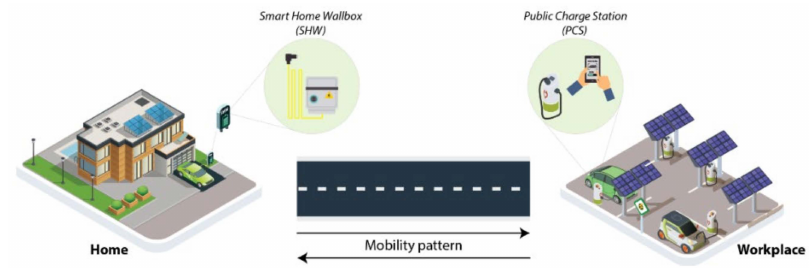
Figure 3. End-user daily mobility routine.